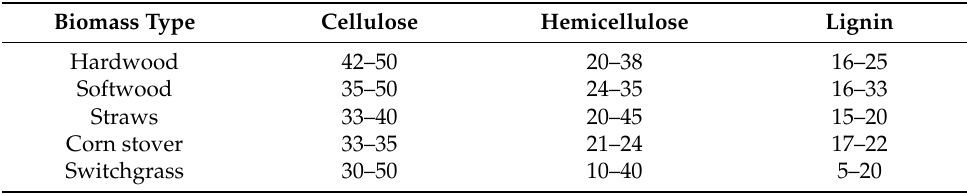
Table 4. Biomass constituents (wt.% on a dry basis) [21,29,47].